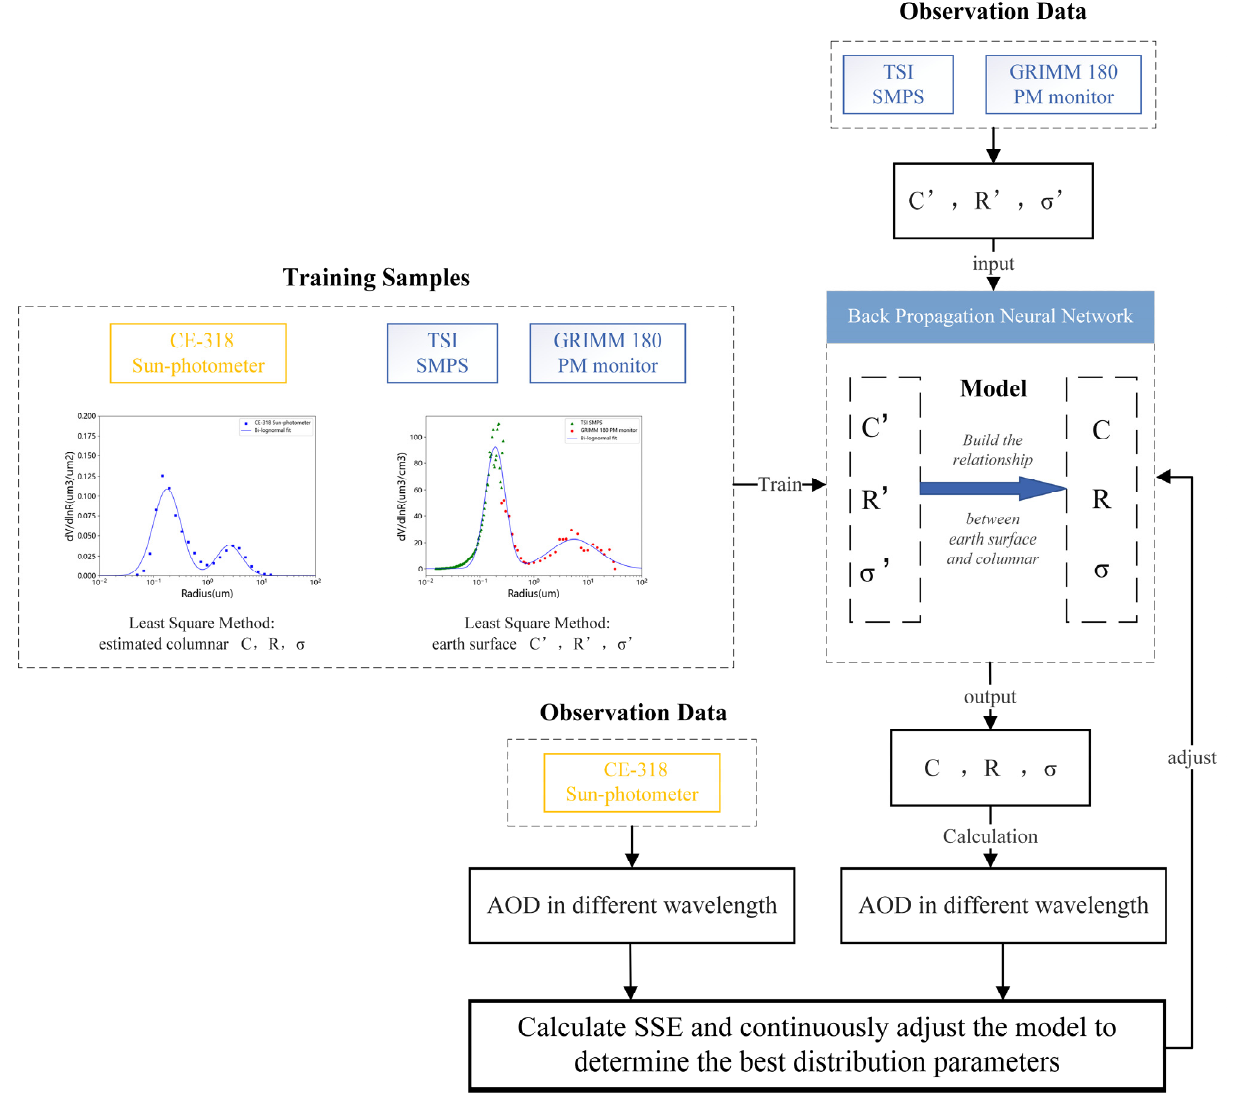
Figure 2. The flowchart of the novel algorithms combined with machine learning.